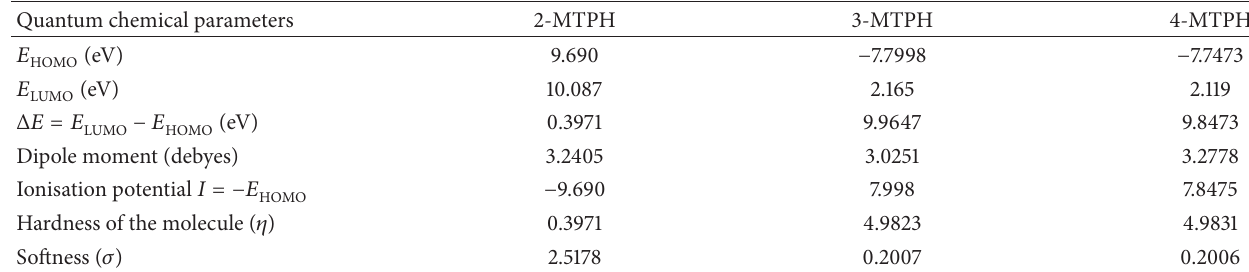
Table 8: List of quantum chemical